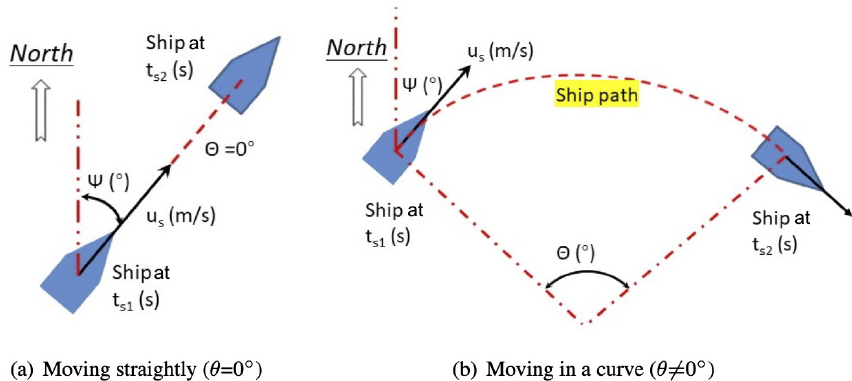
Figure 1. Illustration of the moving point source model. The ship variables in the figures are explained in Table 1. Table 1. Setup of the moving point source